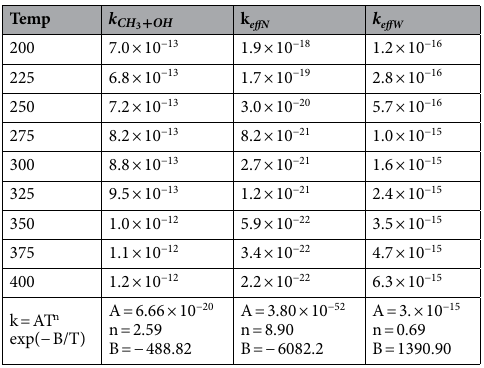
Table 3. Calculated rate coefficients for the OH + CH 3 OH, OH + CH 3 OH + H 2 O and OH + CH 3 OH + NH 3 .